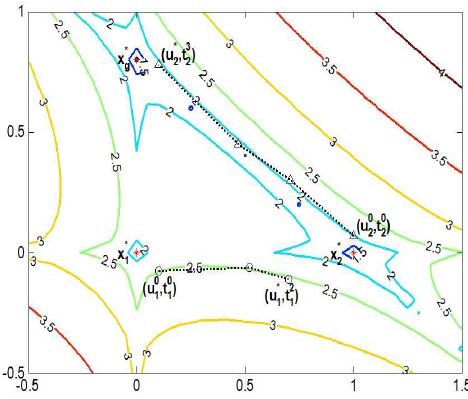
Figure 4. Global convergence process of the energy-level jumping algorithm in the contour